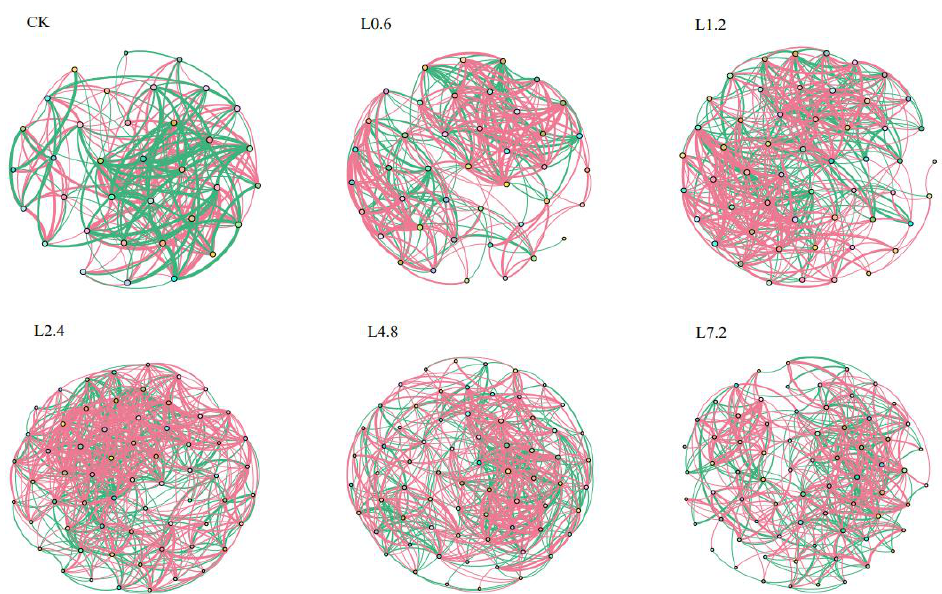
Figure 9. Co-occurrence network of bacterial genera in citrus orchard soil under different lime dosage treatments. Nodes of different colors in the network represent bacteria of different genera, the node size is proportional to the number of connections. Only nodes that are significantly ( p < 0.05) correlated with each other are connected, and the thickness of the edges represents the strength of correlation, with red edges representing positive correlation between bacteria and green edges representing negative correlation between bacteria.